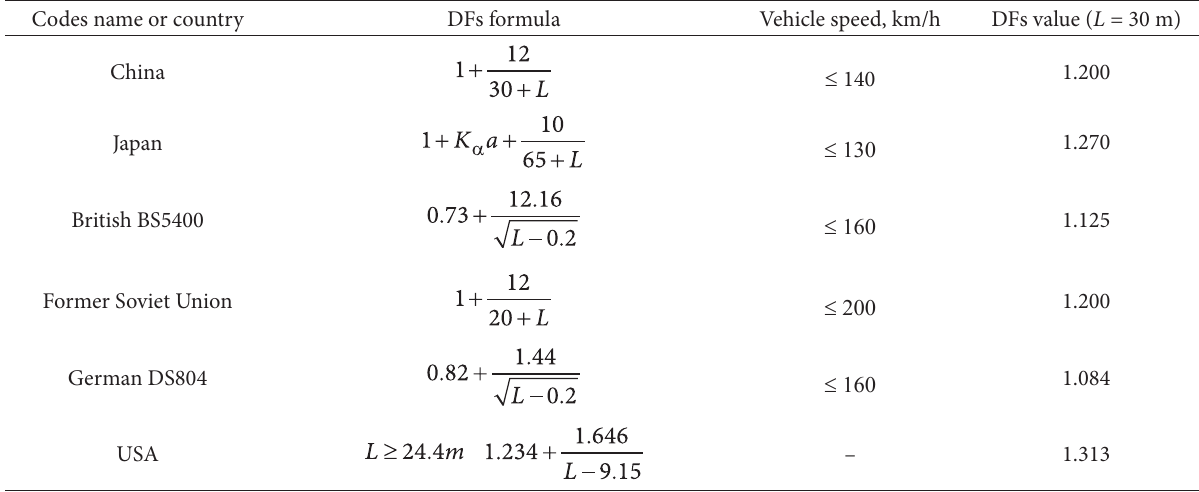
Table 4. Different DFs formulas of railway bridges codes of different countries Codes name or